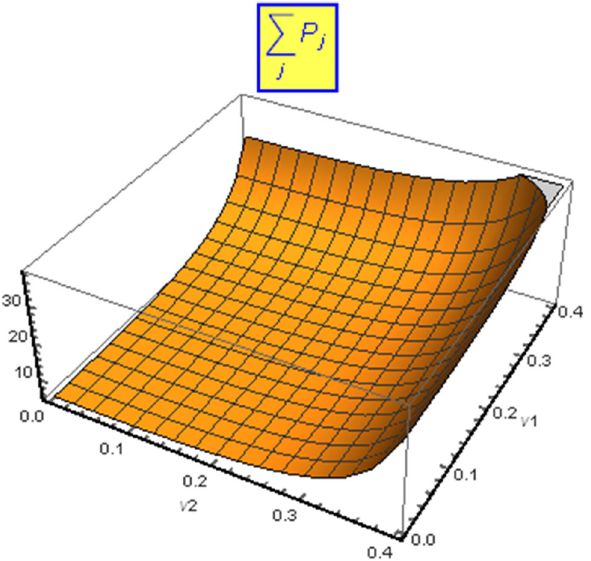
inating from the Lagrangian 12 we have the diagrams 10, 11, 12 and 13. From these Figs., i.e. 10, 11, 12 and 13, it is